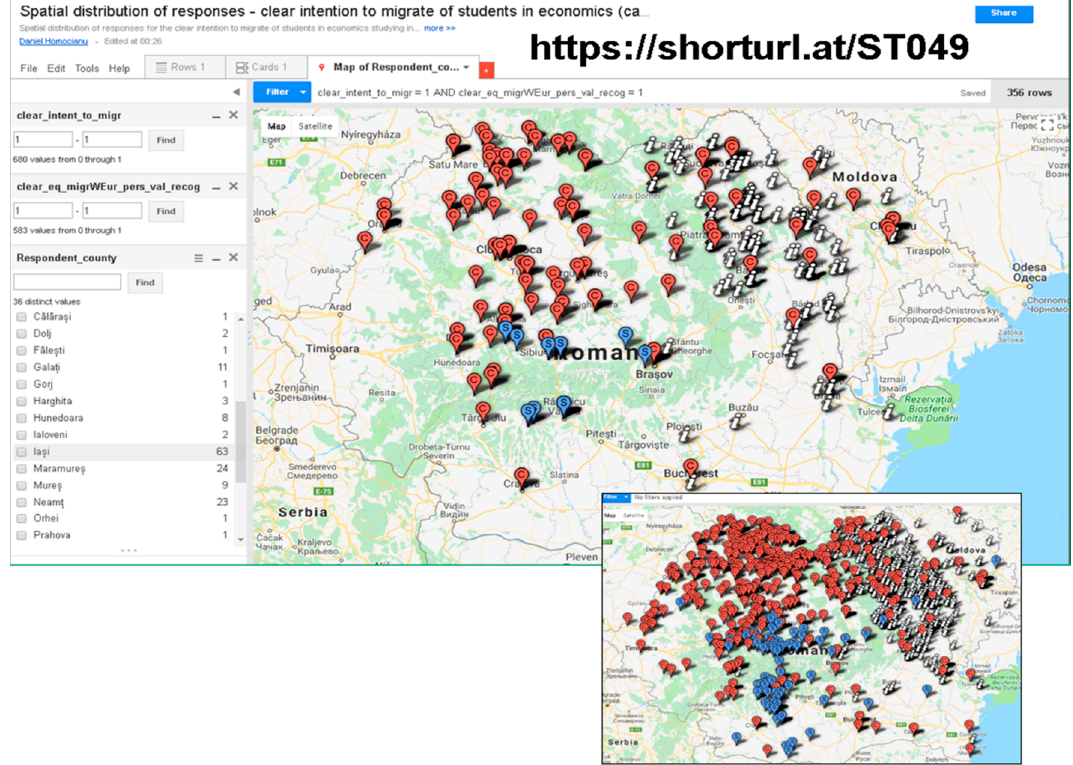
Figure 1. The spatial distribution of responses about the clear intention to migrate as interactive detailed map of coordinates with three iconographic symbols for the university centres the students belong to ( —FEAA, UAIC, Iasi, —FSEGA, UBB, Cluj-Napoca, —FSE, ULBS, Sibiu).